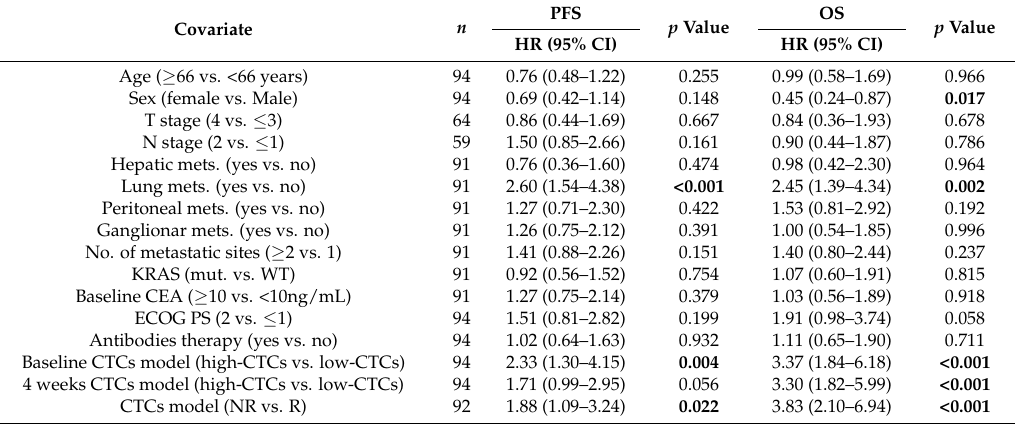
Figure 1. Kaplan-Meier plots of progression-free survival (PFS) and overall survival (OS) according to high or low PrediCTC expression levels at baseline ( A , B ) and four weeks after treatment onset ( C , D ). Table 2. Untivariate Cox proportional hazard regression analysis for progression-free survival (PFS) and overall survival (OS) of patients’ clinical characteristics at baseline and the four-week follow-up PrediCTC multimarker model.